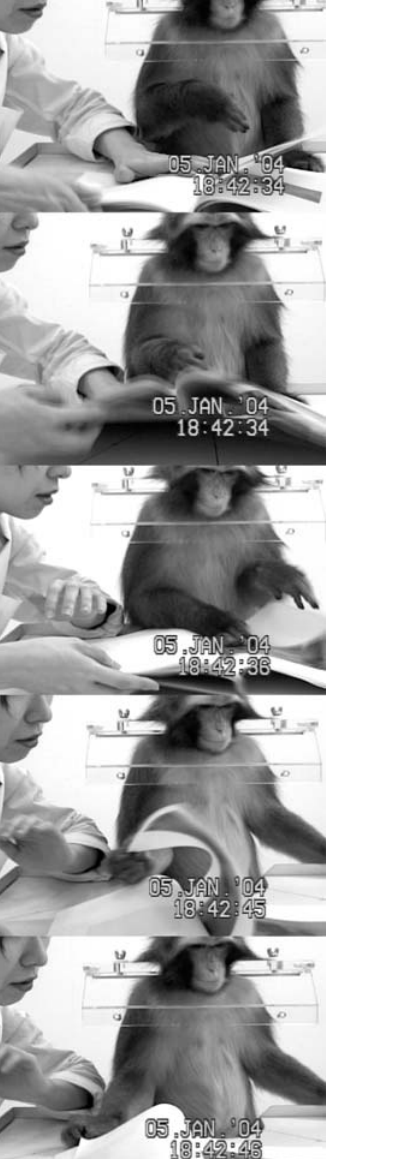
Figure 4. Sequential photographs of turning the pages. The monkey watched the experimenter turning pages and turned the page (top three panels). The monkey turned another page (bottom two